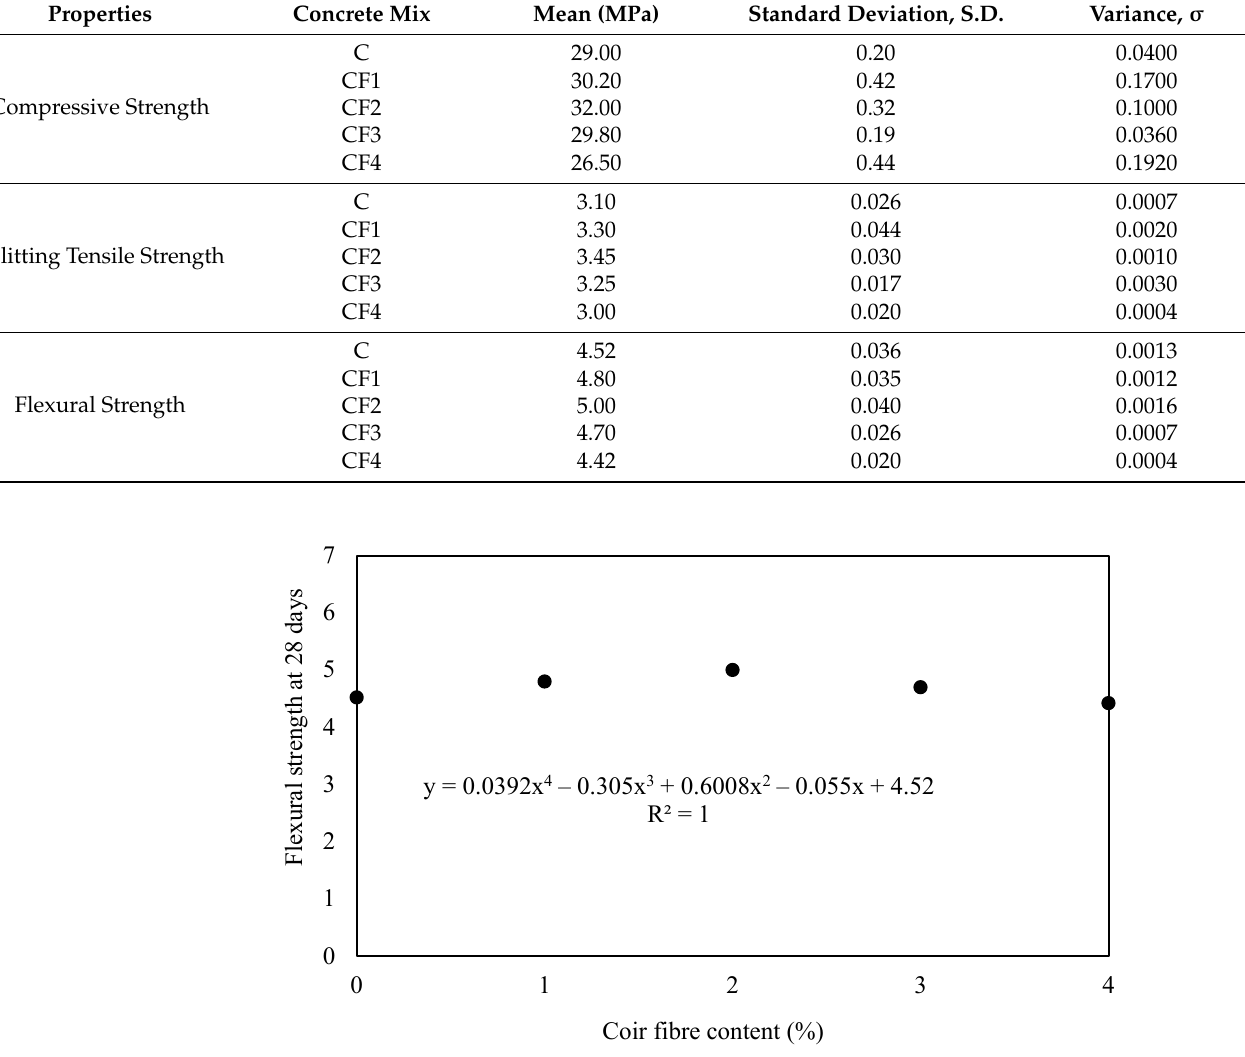
Figure 9. A fourth-degree relationship between the content of coir fiber and the flexural strength of the coir fiber-modified concrete.